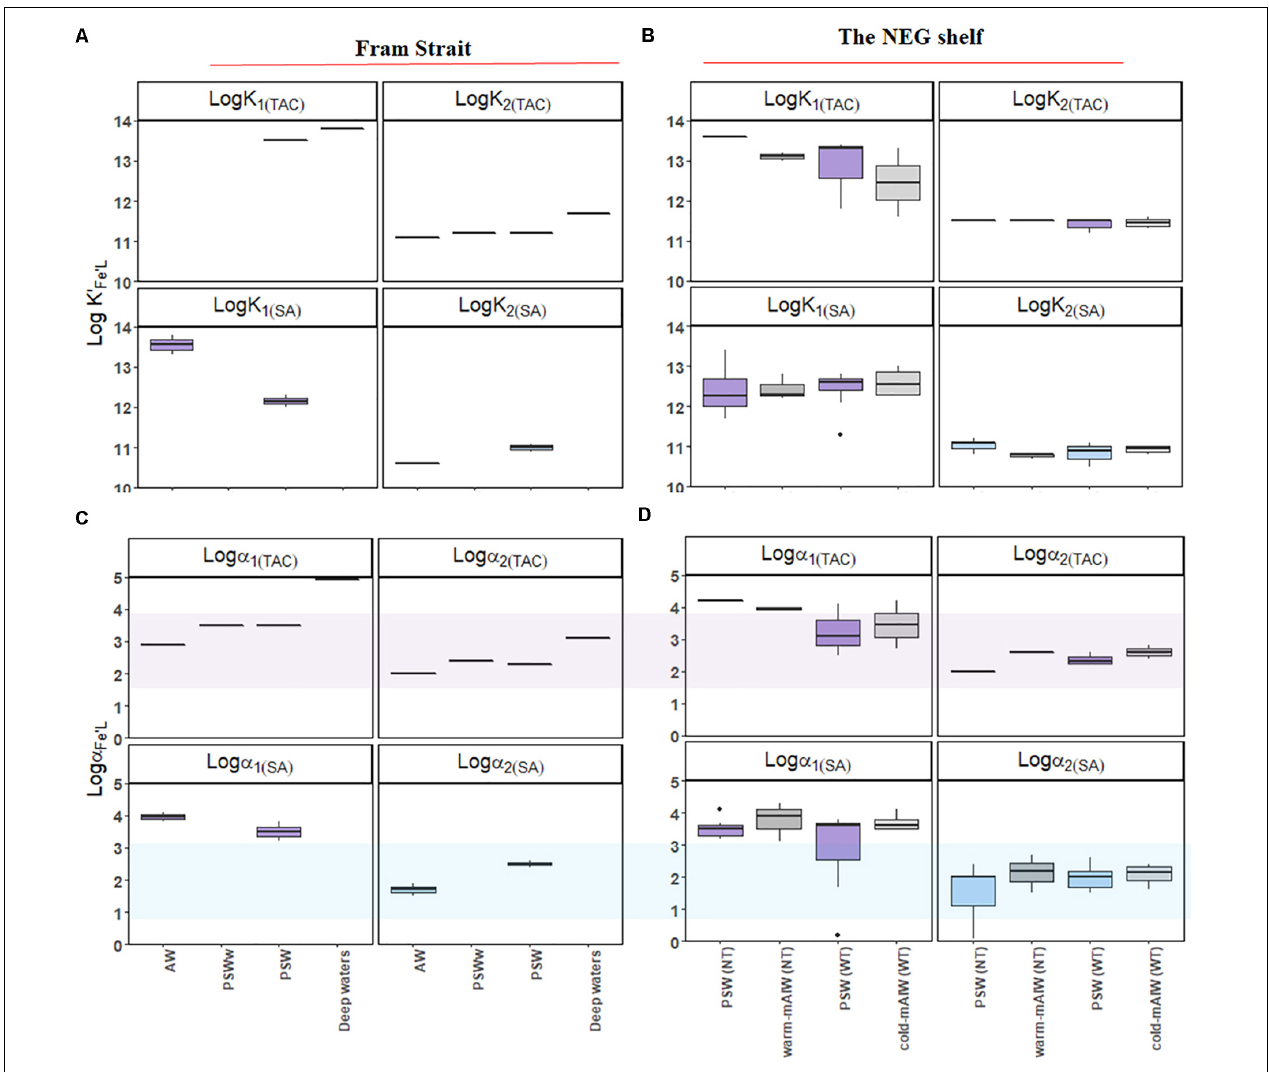
FIGURE 6 | Boxplot of the results from a two-ligand model: the conditional stability constants of the relatively strong (log K (cid:48) 1 ) and weak ligand groups (log K (cid:48) 2 ) from samples (A) from Fram Strait and (B) from the northeast Greenland shelf; side reaction coefficients of the relatively strong (log α 1 ) and weak ligand groups (log α 2 ) from samples (C) from Fram Strait and (D) from the northeast Greenland shelf. The application of TAC and SA are indicated in subscribed letters. The shades in (C) and (D) indicate the detection window (log Dw) for each method. The details of the boxplot are described in Figure 2